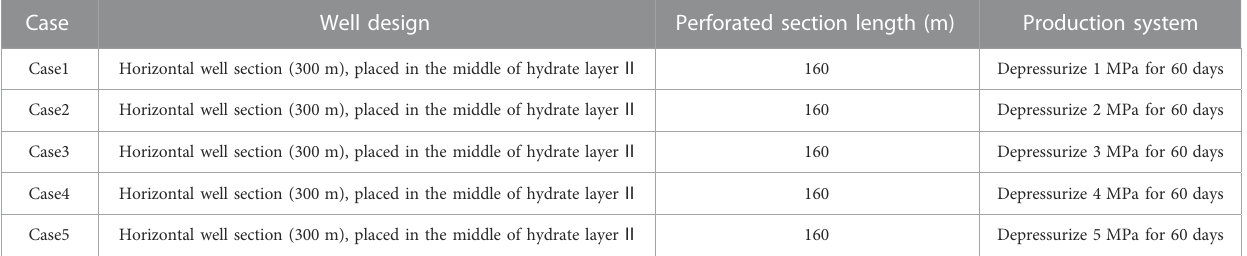
TABLE 6 Optimized the depressurized production system.